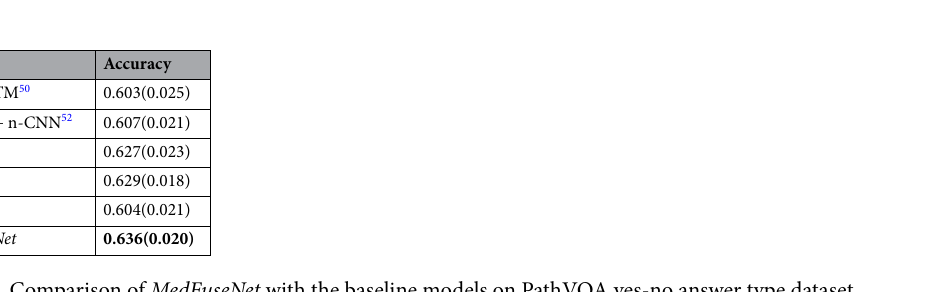
Table 5. Comparison of MedFuseNet with the baseline models on PathVQA yes-no answer type dataset.